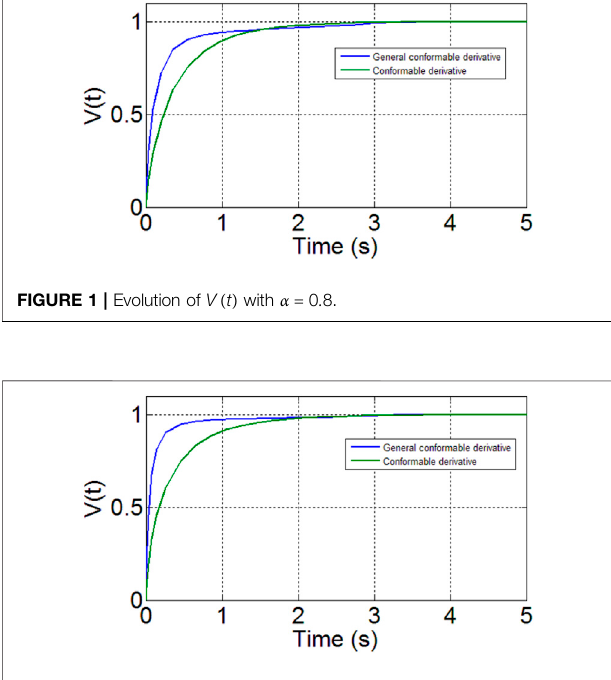
FIGURE 2 | Evolution of V ( t ) with α (cid:2) 0 . 7.